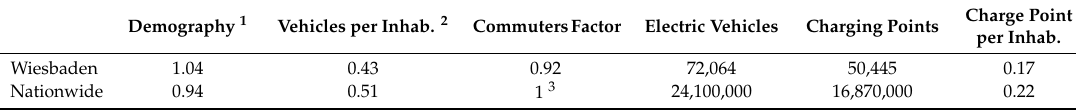
Table 3. Charging points on municipal level: Wiesbaden in 2040 as an application example. Demography 1